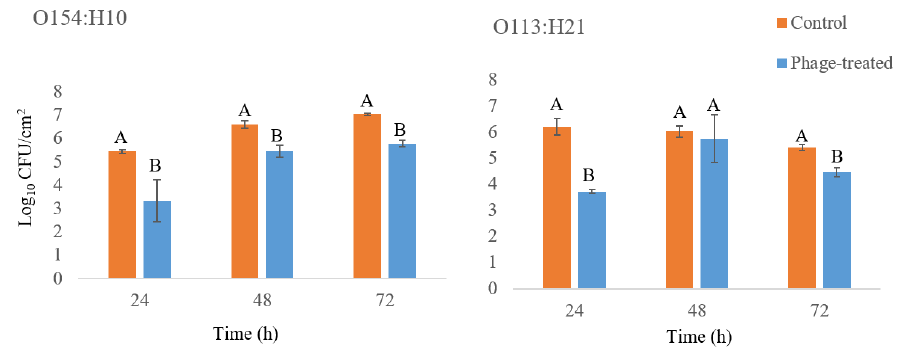
Figure 2. The number of surviving E . coli O154:H10 and O113:H21 cells (log 10 CFU/cm 2 ) associated with biofilms treated or untreated with phage SA21RB (10 13 PFU/mL). Different uppercase letters denote differences at p < 0.05 among phage-treated and control coupons. Bars = standard error ( n = 3).